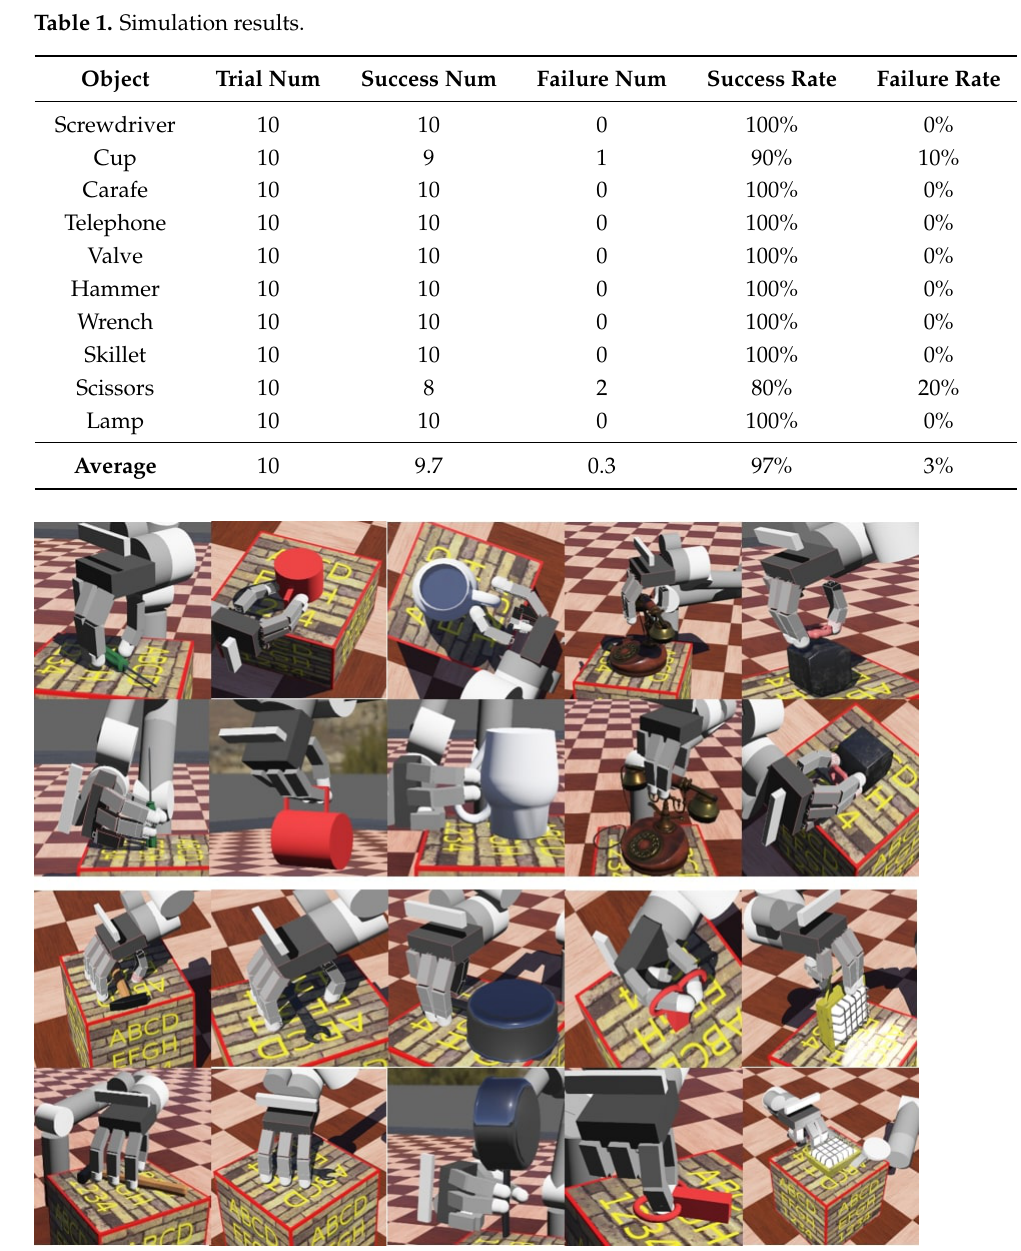
Figure 16. Results in simulation: grasping ten objects in various